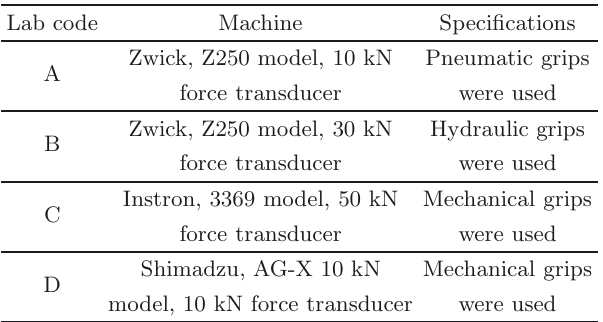
Table 1. The machines used in the measurements and their specifications.